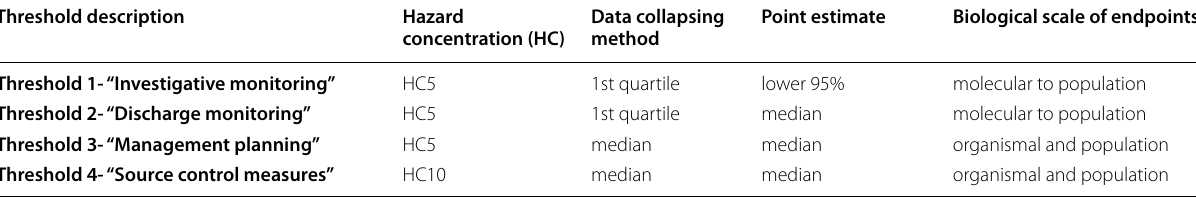
Table 1 Species sensitivity distribution (SSD) parameters and data filters used to derive multiple thresholds as part of the tiered